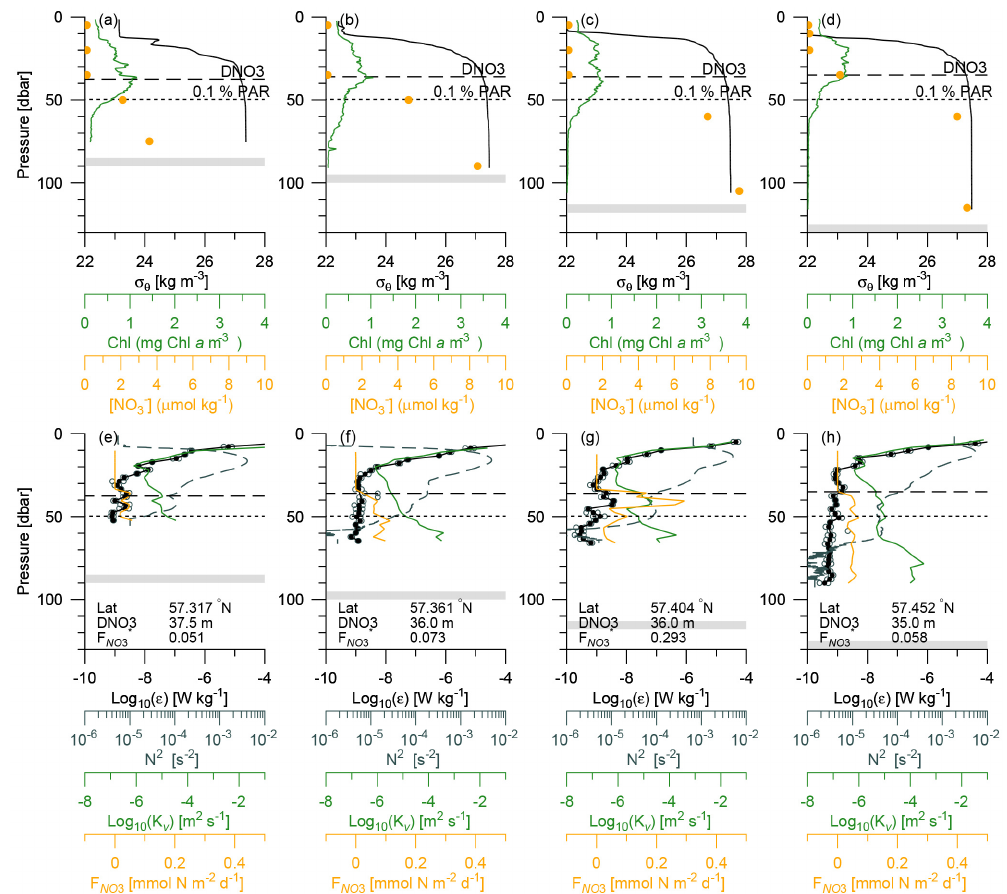
Figure 6. Vertical profiles from four stations across the shelf edge of (a–d) potential density anomaly, chlorophyll a , and nitrate (bullets) and (e–h) dissipation of TKE (average value and values from the two shear sensors are shown by bullets and open circles, respectively), Brunt–Väisälä frequency (dashed line), turbulent diffusion coefficient, and the vertical turbulent nitrate flux. The nutricline depth ( D NO3 ) and depth of the euphotic zone (0.1% PAR) are shown (dashed and dotted lines), and station information of locations, D NO F NO to the euphotic zone are shown in the panels (e) – (h) 3